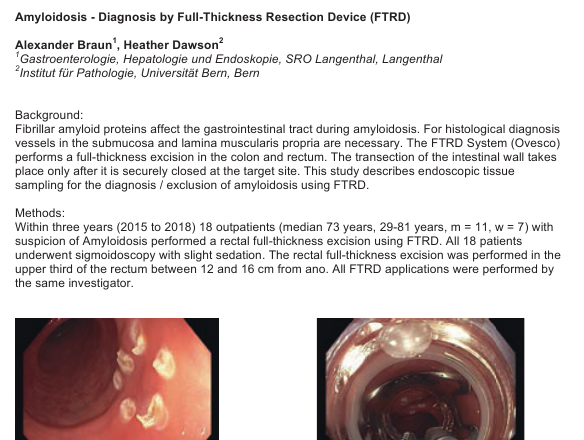
Table: HRQoL PRO’s scores changes in IBD patients according to their type iron therapy compared to male IBD patients, without iron supplementation, without surgery, lower behavior pattern (e.g. B1 for Crohn), without anti-TNFs or immunomodulation (as reference).